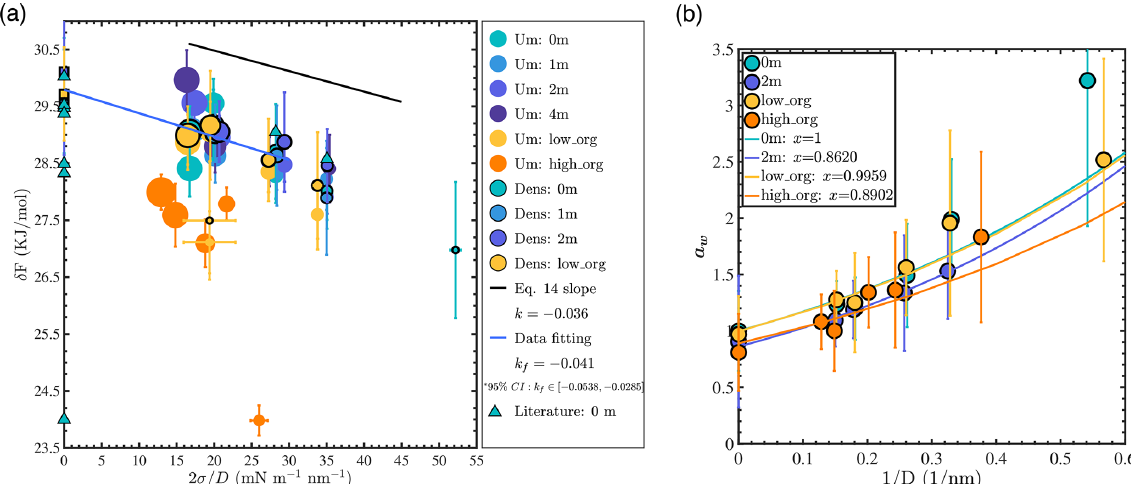
Figure 5. (a) Water evaporation free energy calculated from the density profile in equilibrium MD simulations (“Dens”) or from the umbrella sampling method (“Um”): the black line shows the reference slope of δF versus 2 σ/D from the classical Kelvin equation prediction; the blue line shows the best linear fit obtained for well-mixed NaCl systems with droplet sizes larger than 3.5nm ( N w ≥ 1000). Marker size is scaled with droplet size. Literature data were collected from previous MD simulations carried out using the SPC/E water model (Garrett et al., 2006; Li et al., 2018; Varilly and Chandler, 2013). (b) Water activity a w (circles) versus 1 /D for different droplets: colored lines show best fits obtained using Köhler theory (Eq.